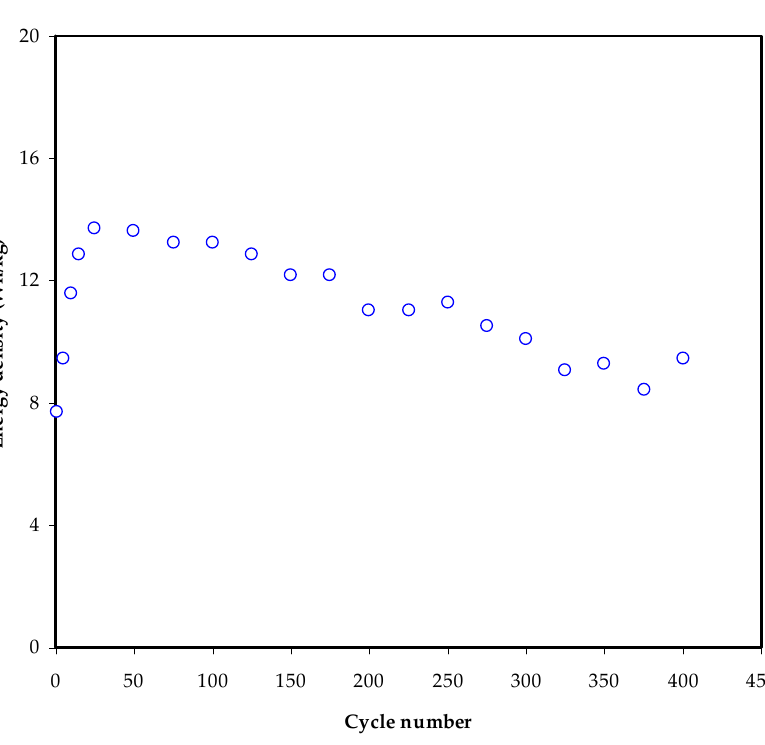
Figure 12. The energy density ( E d ) for the assembled EDLC throughout 400 cycles.